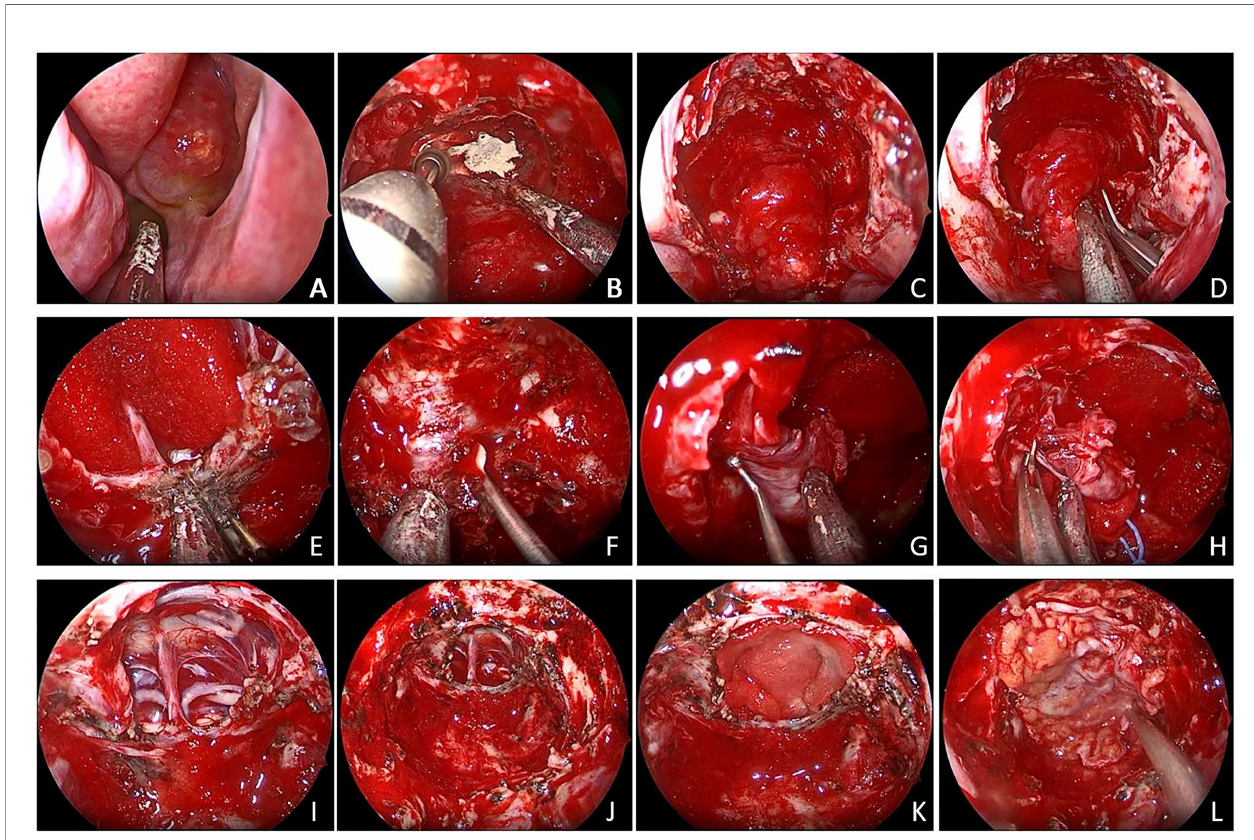
FIGURE 2 | (A) The tumor broke through the sphenoid sinus and grew to the nasal cavity. (B, C) An extended transnasal approach was performed. (D) Decompression inside the tumor. (E) Removal of the saddle septum attached to the base of the tumor. (F – H) Remove the adhesion tissue between the tumor and the cavernous sinus and internal carotid artery. (I) Pituitary stalk was preserved. (J – L) Tumor was gross total